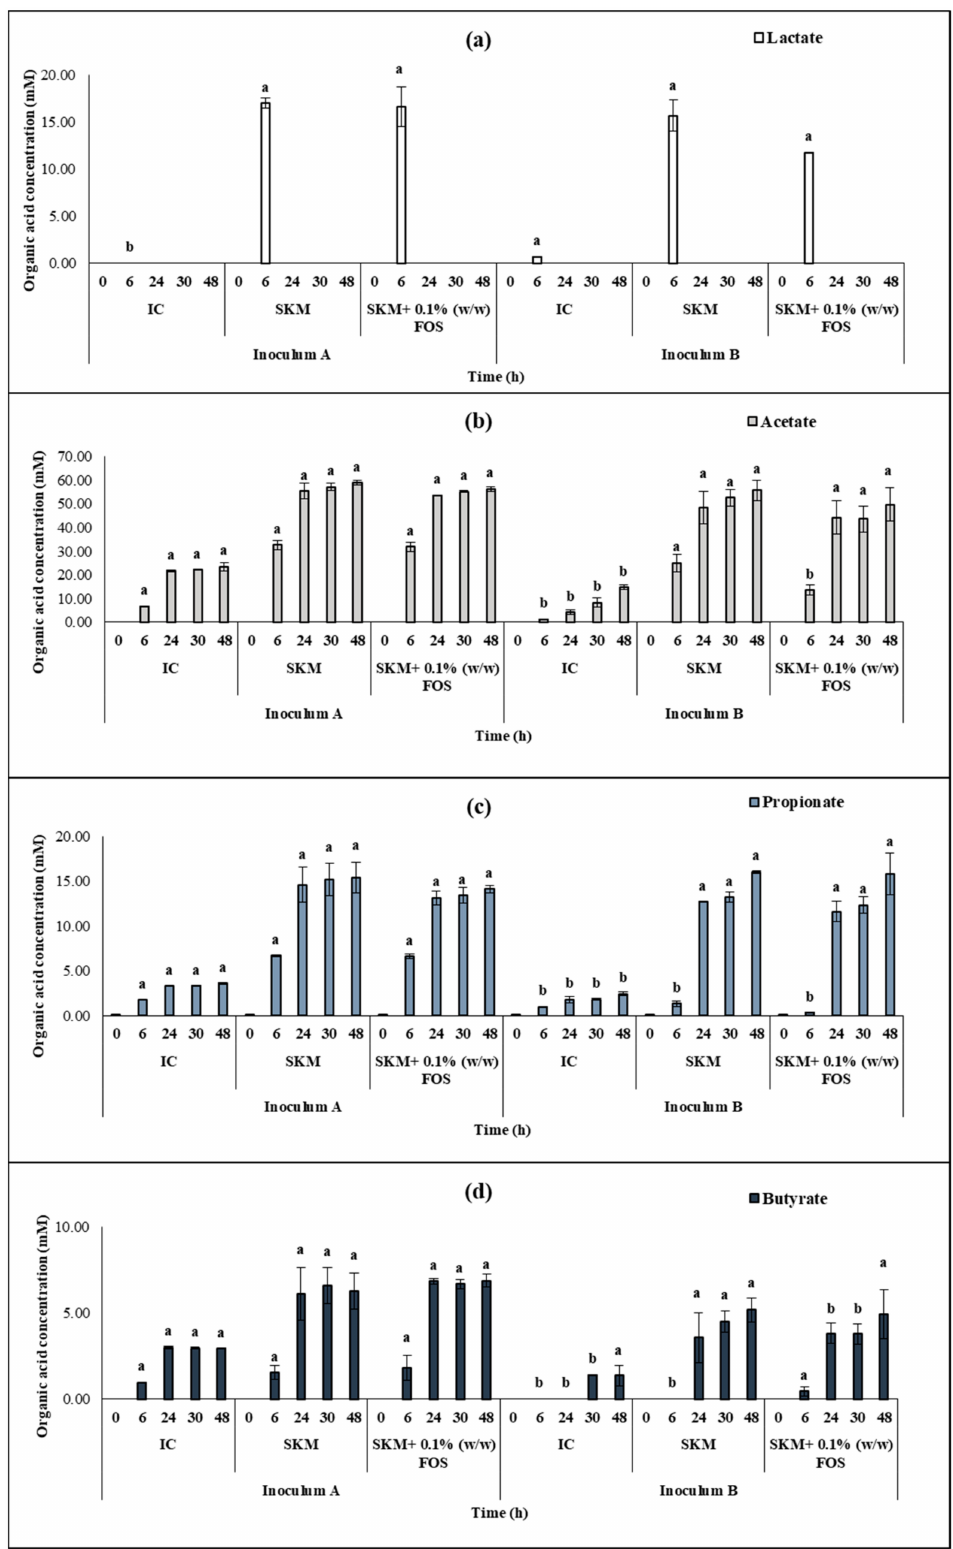
Figure 6. Concentration (mM, means ± SD) of the SCFA and lactate produced during 48 h of colonic fermentation using a fresh inoculum (A) and frozen inoculum (B). ( a ) Lactate; ( b ) acetate; ( c ) propionate; ( d ) butyrate. Different letters mark statically significant ( p < 0.05) differences between the same conditions at each sampling time, in each inoculum. FOS—fructo-oligosaccharides; IC—inoculum control; SKM—skimed